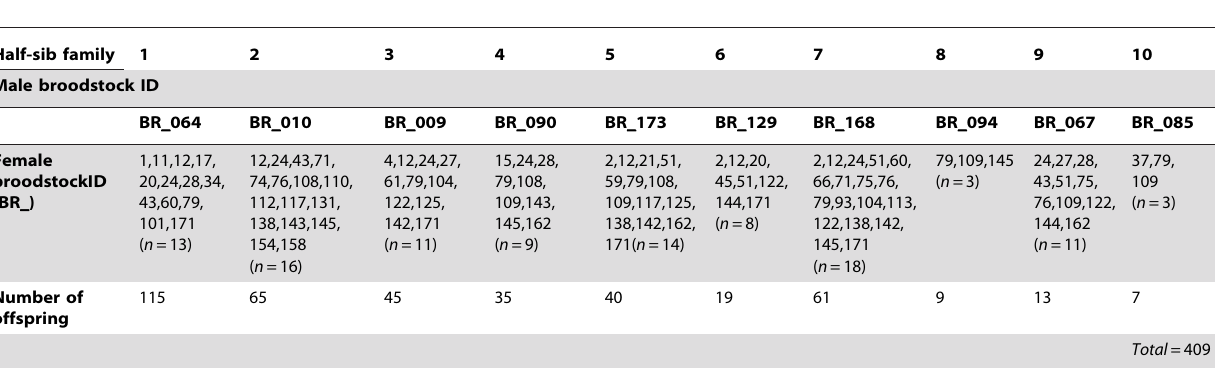
Table 1. Pedigree structure, derived from parentage analysis, comprising of ten paternal half-sib families with totally 409 sea bream